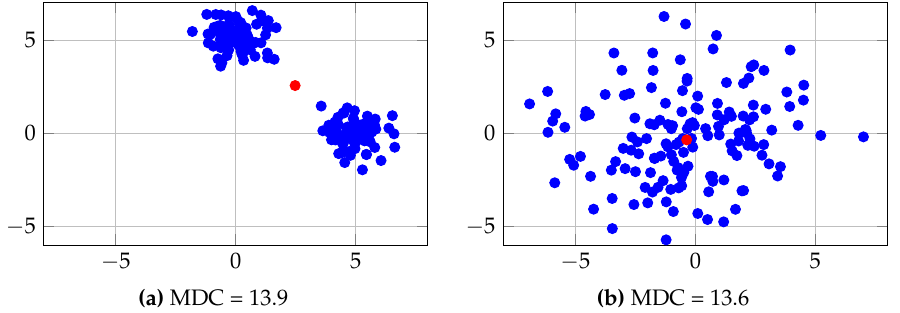
Figure 4. Simulated pixels’ distributions for two different plots ( a ) and ( b ). Pixels are displayed in blue, and the centroids of the plots are displayed in red. The estimated MDC are very close while the spectral distributions of the plots are clearly